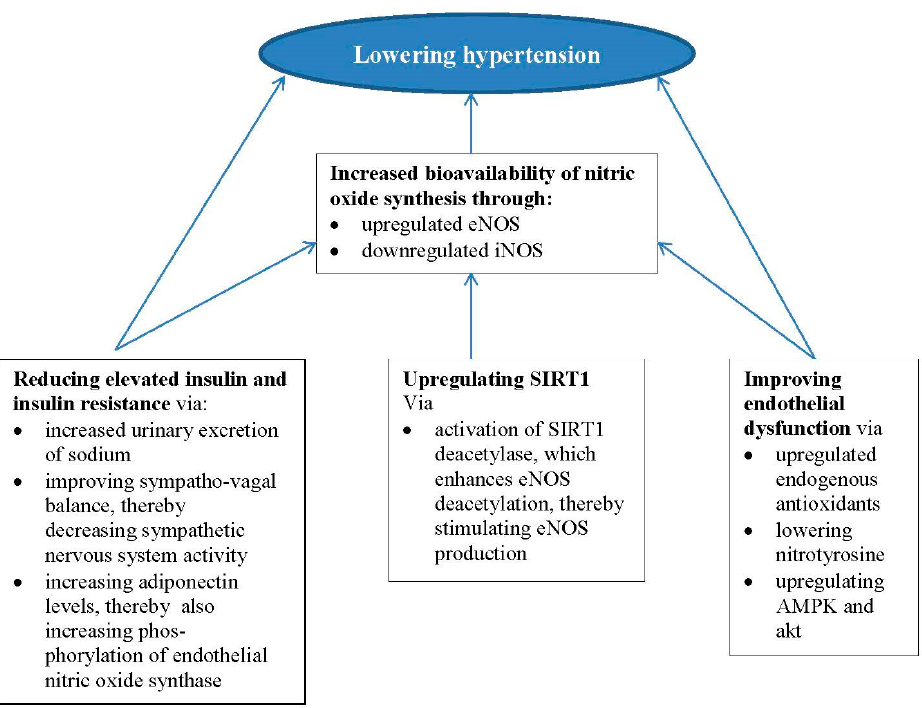
Figure 1. Potential mechanisms of the effects of CR on hypertension.